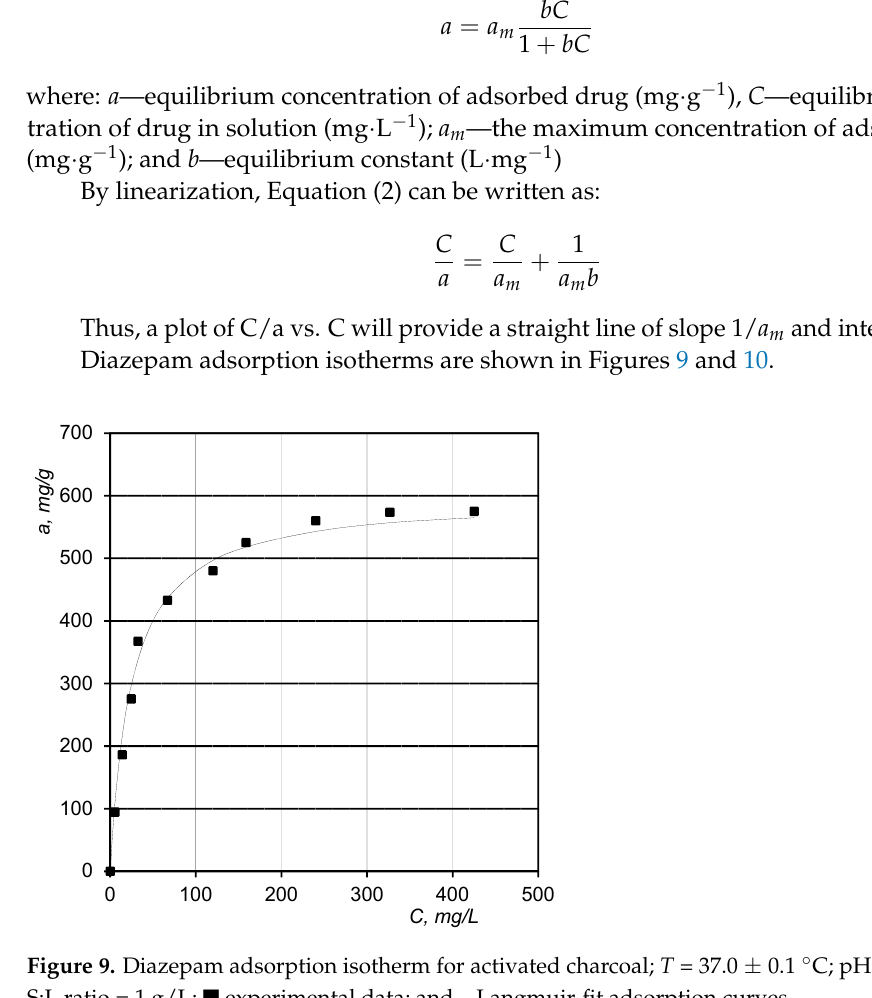
Figure 9. Diazepam adsorption isotherm for activated charcoal; T = 37.0 ± 0.1 ◦ C; pH = 6.80 ± 0.05; S:L ratio = 1 g/L; ▪ experimental data; and — Langmuir-fit adsorption curves.